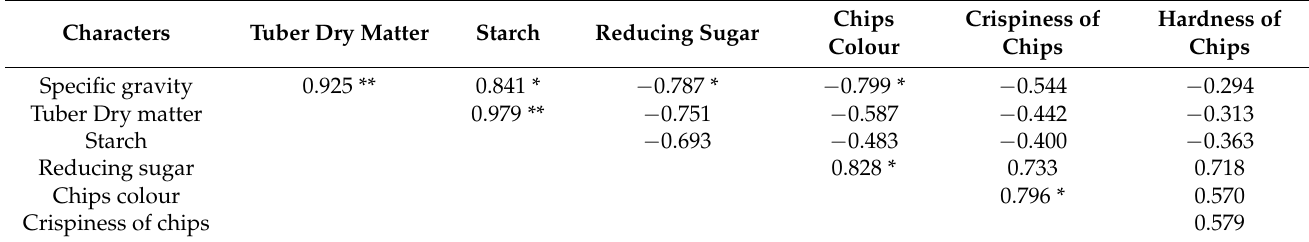
Table 2. Correlation studies for various quality parameters of different processing type